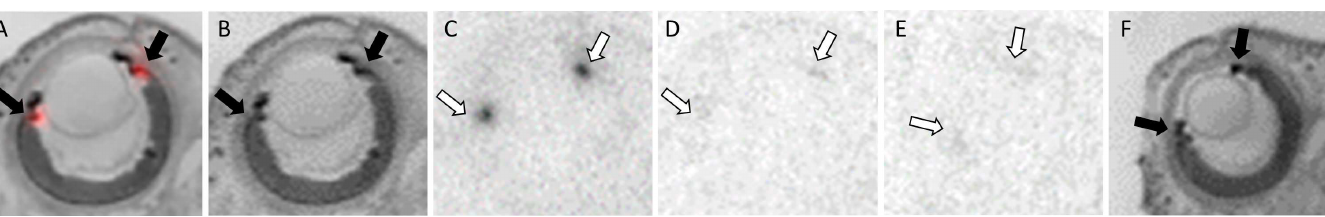
PLOS ONE | DOI:10.1371/journal.pone.0172904 February 24,